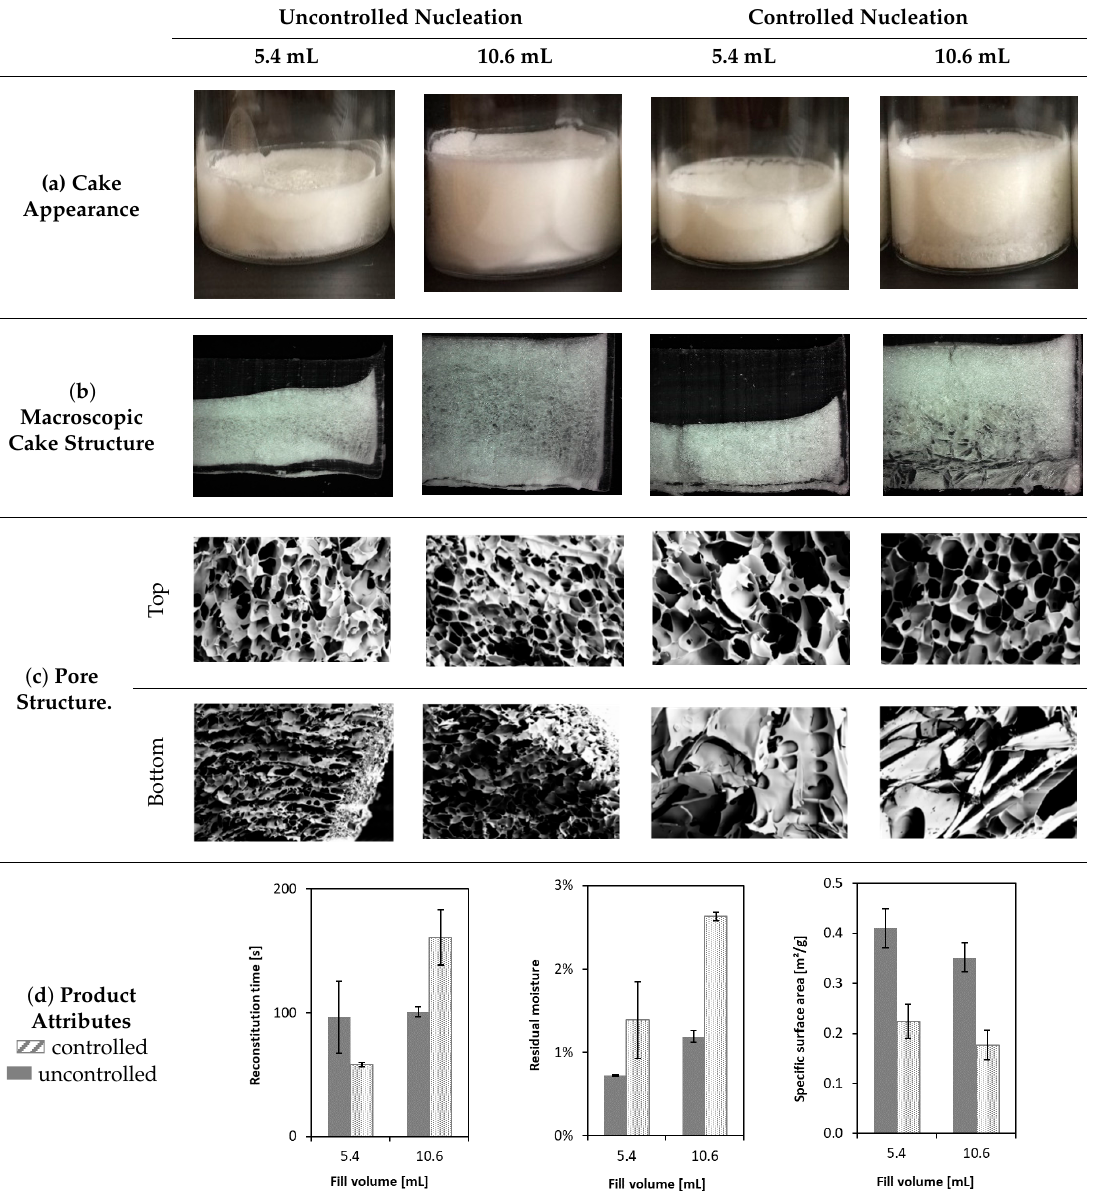
Macroscopic Cake Structure